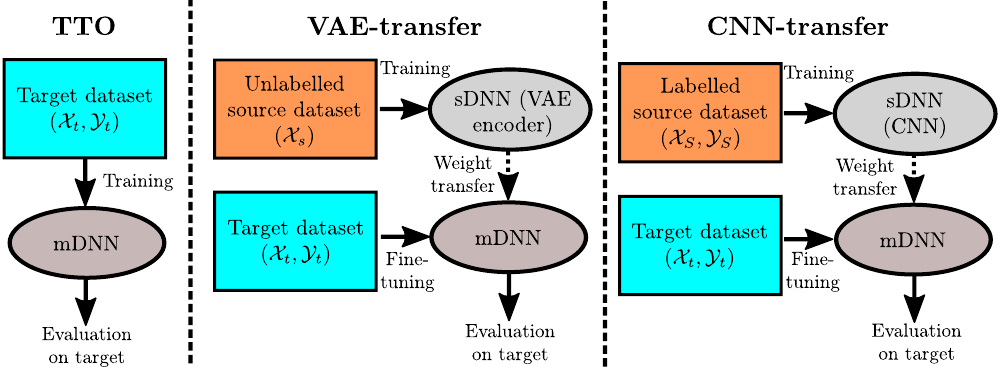
Figure 4. Flowchart of the three approaches tested on the CogAge dataset: TTO (no transfer), VAE-transfer, and CNN-transfer. The mDNN follows the architecture described in Figure